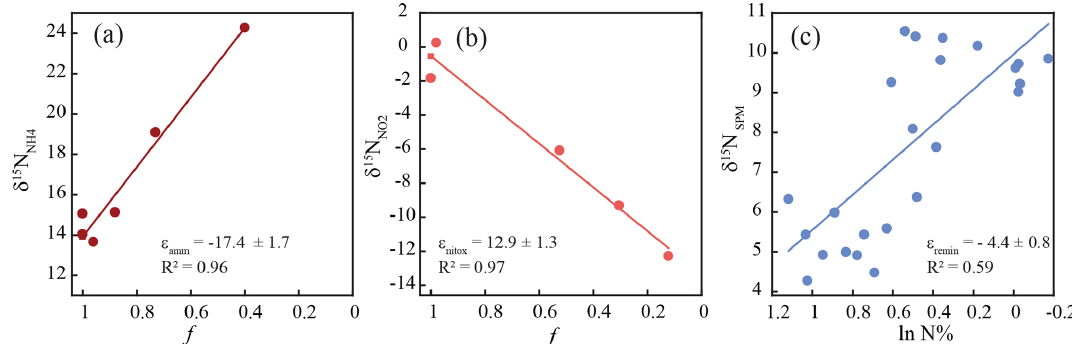
Figure 4. Overview of calculated fractionation factors for the turnover of (a) ammonium, (b) nitrite, and (c) particulate nitrogen along the discussed stretch of the Elbe River. “ f ” denotes the remaining fraction of the respective substrate. The reader is referred to Sects. 2.7 and 3.3 for details of the